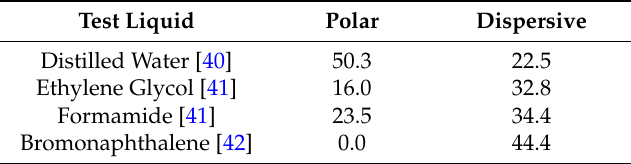
Table 2. Dispersive and polar surface energy components (mN ¨ m ´ 1 ) for selected test liquids from the